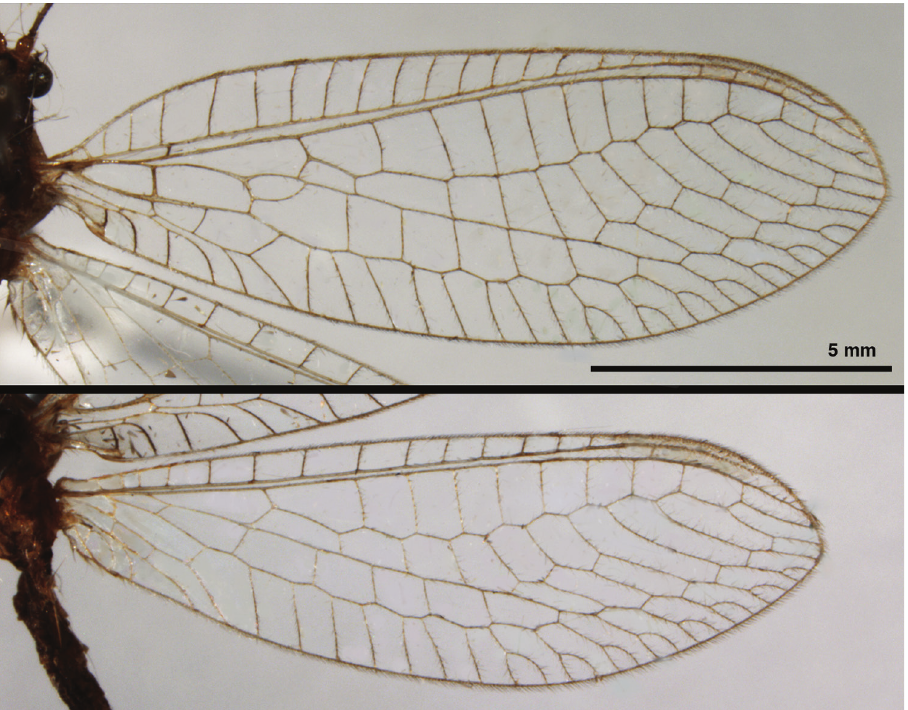
Figure 32. Ungla diazi Sosa: Wings (Bolivia, Cochabamba, male, metathorax cream-colored to tan mesally, marked with light brown to brown laterally. Legs pale, cream-colored, without marks. Measurements: head width: 1.4–1.5 mm; ratio head width : eye width: 2.5–2.7 : 1; prothorax width: 1.1–1.2 mm, length: 0.5–0.7 mm. Forewing, hindwing rounded apically; membrane clear, largely without fumose ar- eas. Forewing with veins uninflated, except basal section of Psc slightly crassate (male & female); stigma lightly opaque, with four to five, tan to brown subcostal crossveins be- low stigma, small area surrounding crossveins sometimes marked with brown; longitu- dinal veins mostly light tan; transverse veins slightly darker, especially costal, distal radial crossveins, anal veins, all usually without suffusion, occasionally light suffusion around anal veins. Hindwing venation pale. Forewing 12.1–14.7 mm long, 4.1–5.1 mm wide (ratio, L : W = 2.9–3.0 : 1), height of tallest costal cell 0.8–1.1 mm (cell number 5–6); length of first intramedian cell 0.8–1.0 mm; 10–11 radial cells (closed cells between R and Rs); 4 Banksian cells (b cells), 4 b’ cells; 4–6 inner gradates, 6–7 outer gradates. Hindwing 10.7–13.1 mm long, 3.3–4.4 mm wide (ratio, L : W = 3.0–3.1 : 1), 10–11 radial cells, 3–4 Banksian (b) cells, 3–4 b’ cells, 3–6 inner gradates, 5–7 outer gradates. Male. Abdomen with unenlarged spiracles (e.g., A7: spiracle diameter ~0.05x length of sternite); subanal plate large, with ~ten robust setae; T9+ectoproct short, with dorsal invagination shallow, extending approximately one half the distance to anterior margin of T9, lateral margins of invagination slightly convex; dorsal margin